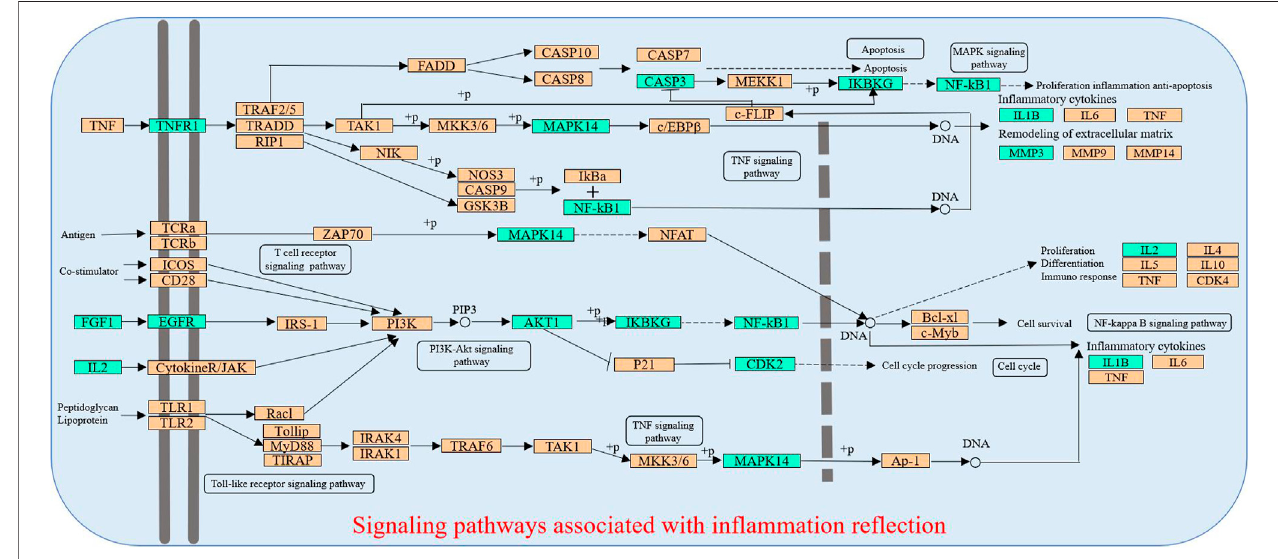
FIGURE 4 | Distribution of partial targets of LCS on the compressed pathways. Note: The cyan nodes are potential targets of LCS, while the orange nodes are relevant targets in the pathway.